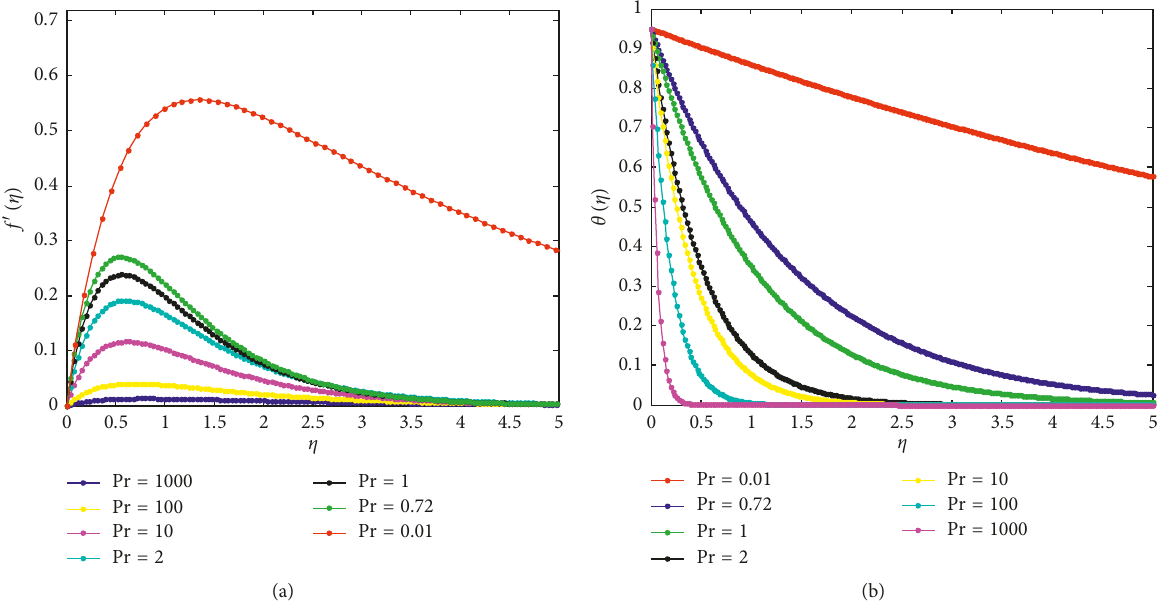
Figure 7: (a) Effects of Prandtl number on the velocity profile when ϕ � 0.040. (b) Effects of Prandtl number on the temperature profile when ϕ �